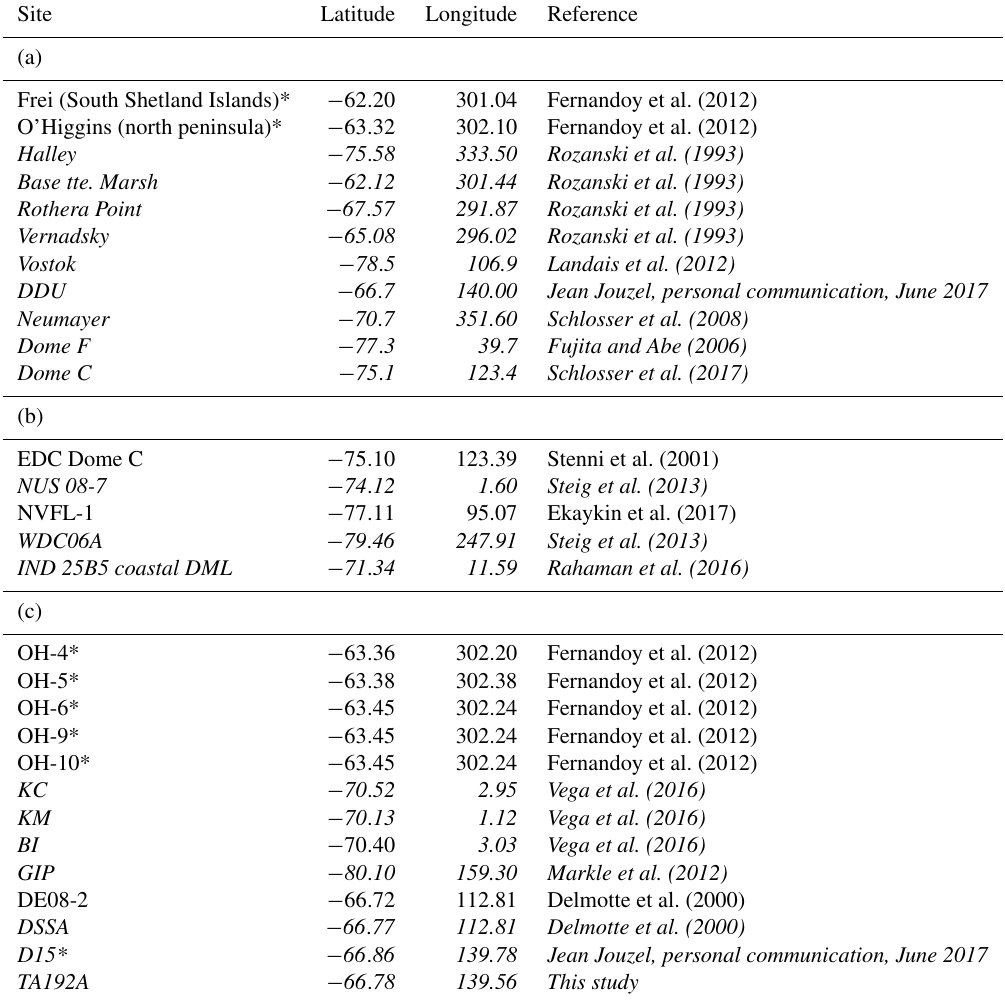
Table 1. Site, latitude ( ◦ ), longitude ( ◦ E), and reference of new d -excess data added to Masson-Delmotte et al. (2008). Data in (a) correspond to precipitation, (b) data correspond to ice cores extracted from the Antarctica2k database (Stenni et al., 2017), and (c) data are new data compared to our prior database (Goursaud et al.,